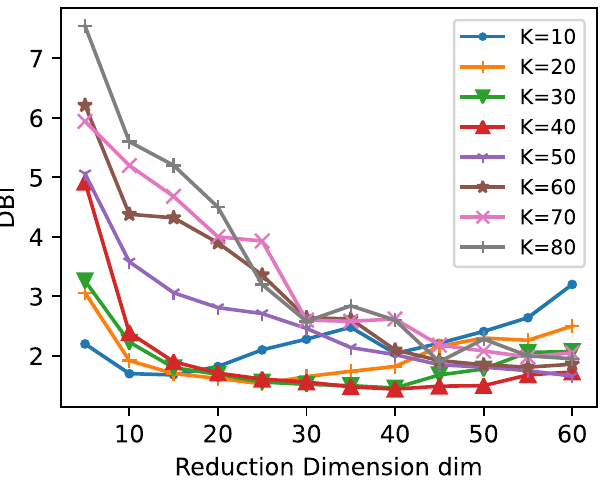
Figure 7. The observation of dimension reduction dim. Dim is regarded as the changing parameter, while K is the invariable parameter. When K ∈ [ 10,40 ] , first, the DBI value decreases, and then increases with an increase in the dim value. When K ∈ [ 50,80 ] , the DBI value decreases with an increase in the dim value.